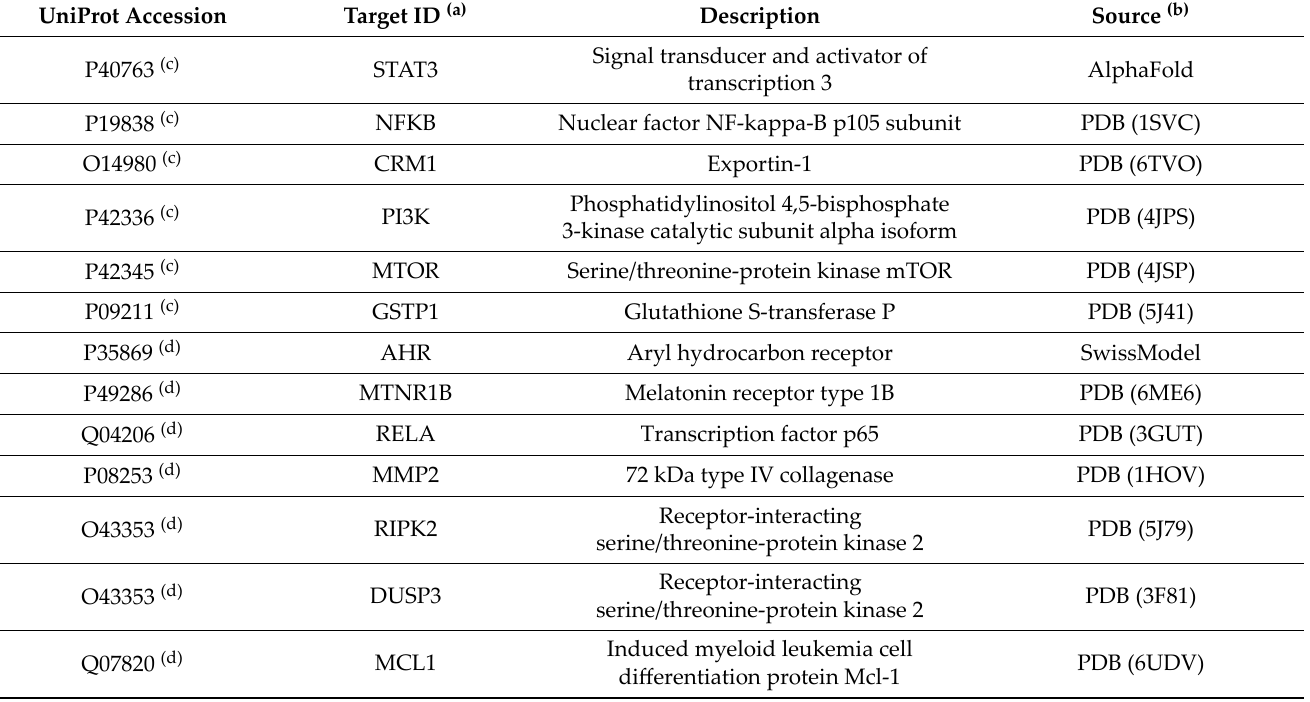
Table 4. Potential molecular targets of compound 9